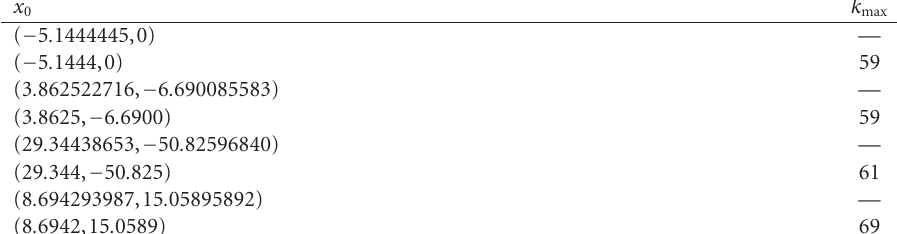
Table 5.3. Cases of convergence and of nonconvergence for Newton algorithm.